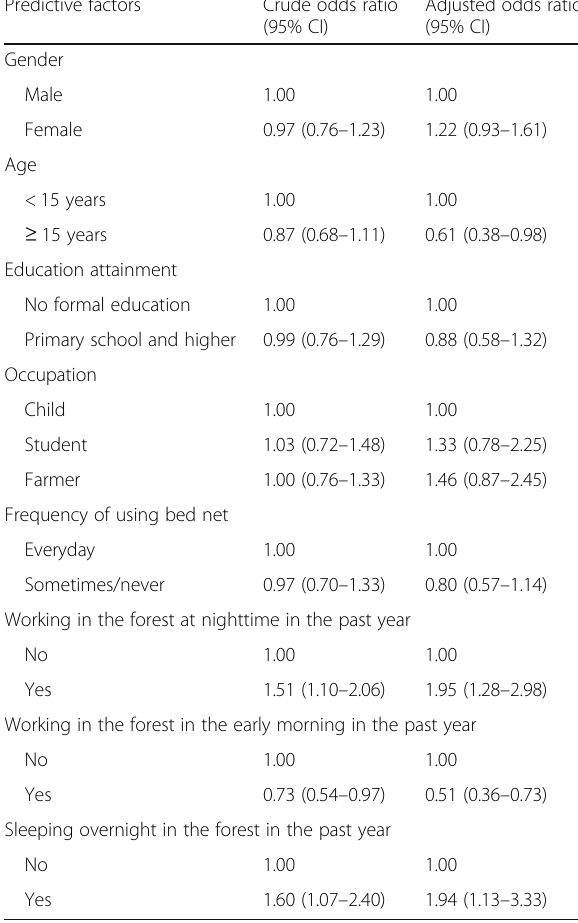
Table 3 Multivariate analysis of differences in individual-level characteristics and case-control